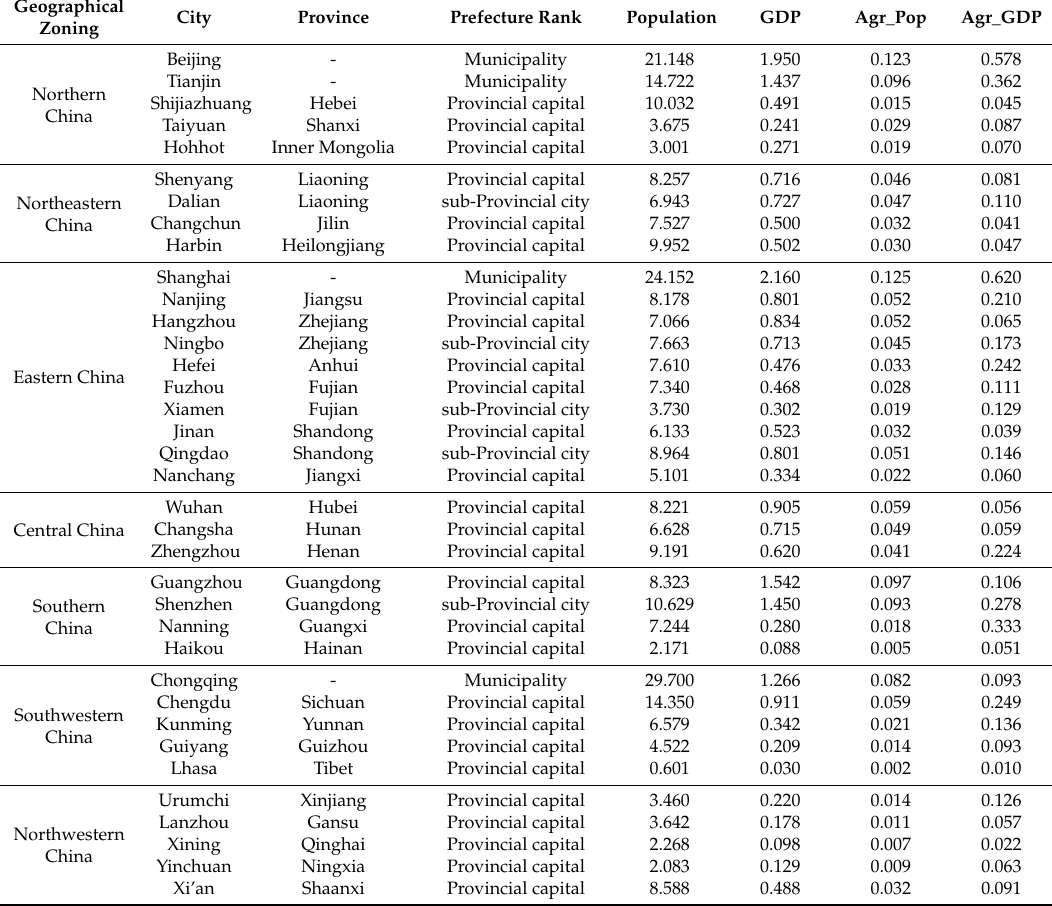
Table 1. Description of 36 key cities [31] in China.